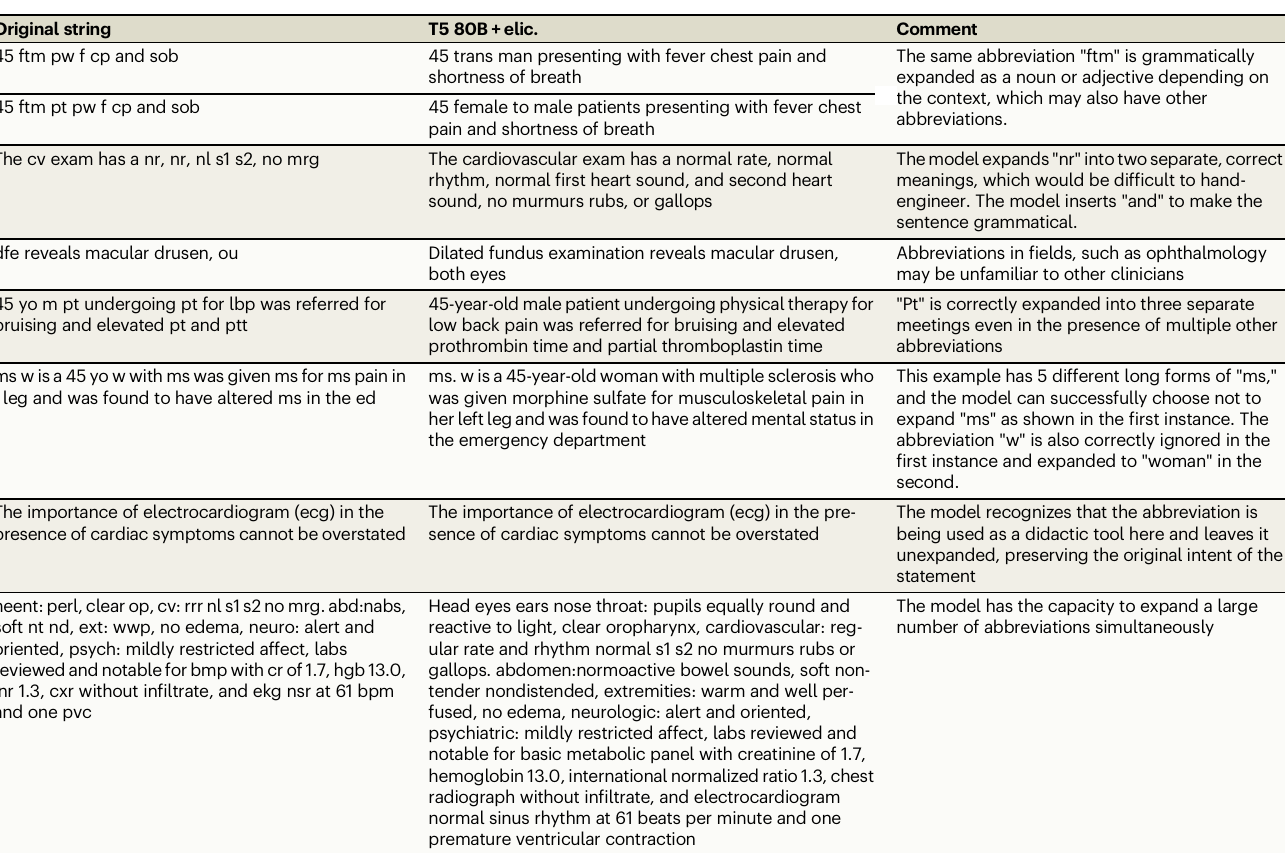
Table 3 | Illustrative demonstration of model capabilities Original